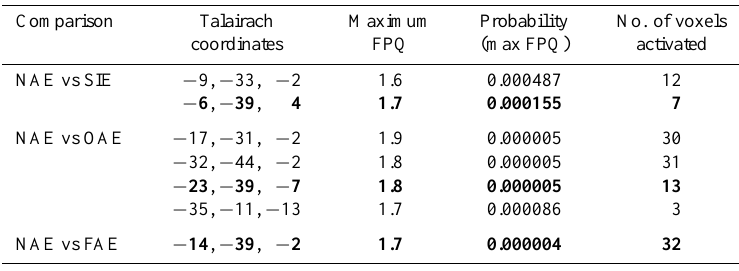
Fig. 2. Four activation maps superimposed on an SPGR image transformed into the standard stereotactic space of Talairach and Tournoux 15 . All four images are coronal sections at y = − 40mm. Left hemisphere of the brain corresponds to right side of image. Panels a, b and c show voxels activated ( p < 0 . 001 by randomisation – see text) in the NAE condition relative to (a) SIE, (b) OAE and (c) FAE. Panel d shows only those voxels activated in the NAE condition in two or more of these three comparisons. Table 2 Summary of left MTL activations in each of the three comparisons. Activations in ‘bold’ are the posterior MTL activations which contribute to those seen in